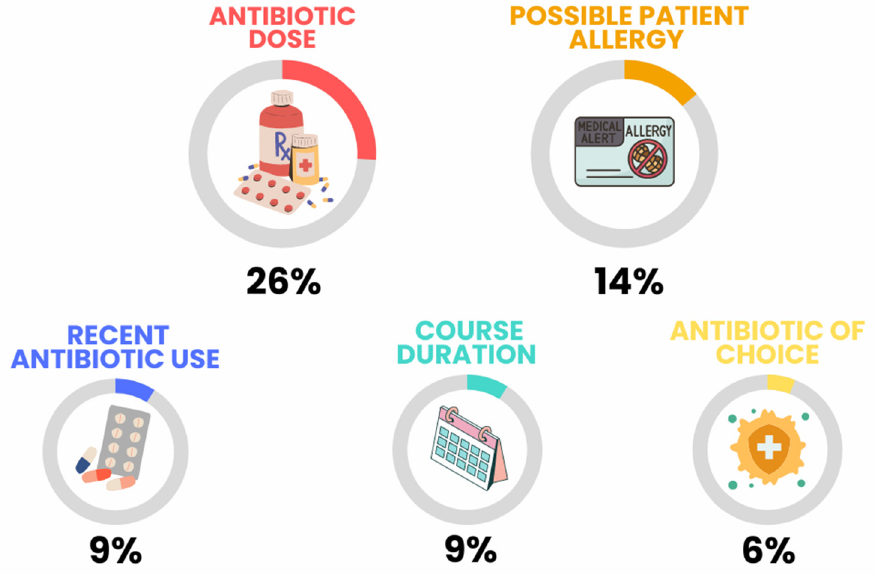
Figure 3. Summary of content analysis themes of why pharmacists contacted a prescriber for 2741 TARGET Antibiotic Checklists .